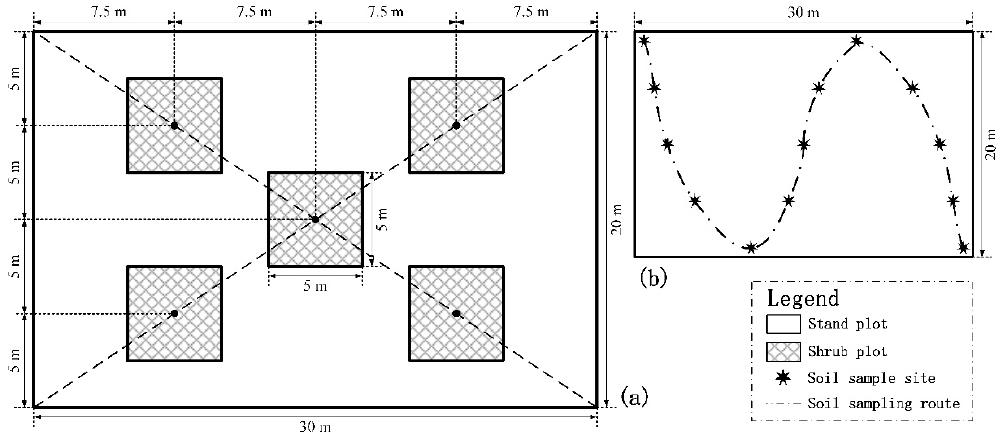
Figure 1. Shrub quadrats position ( a ) and the strategies of soil sampling ( b ).